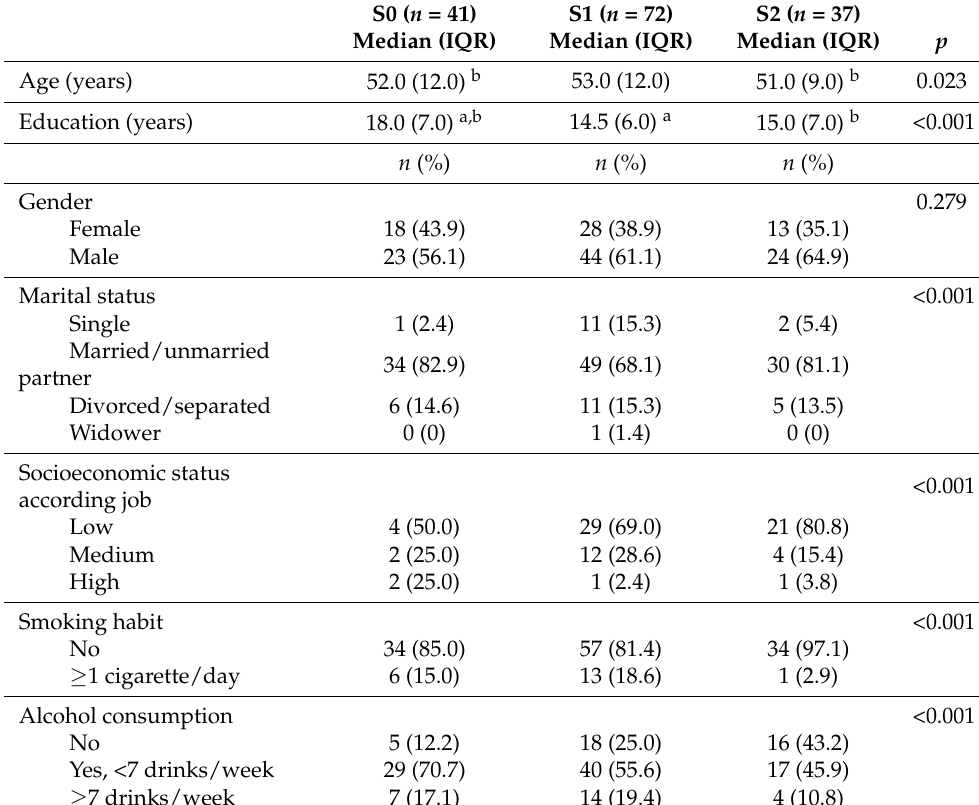
Table 1. Sociodemographic characteristics according to stages of hepatic